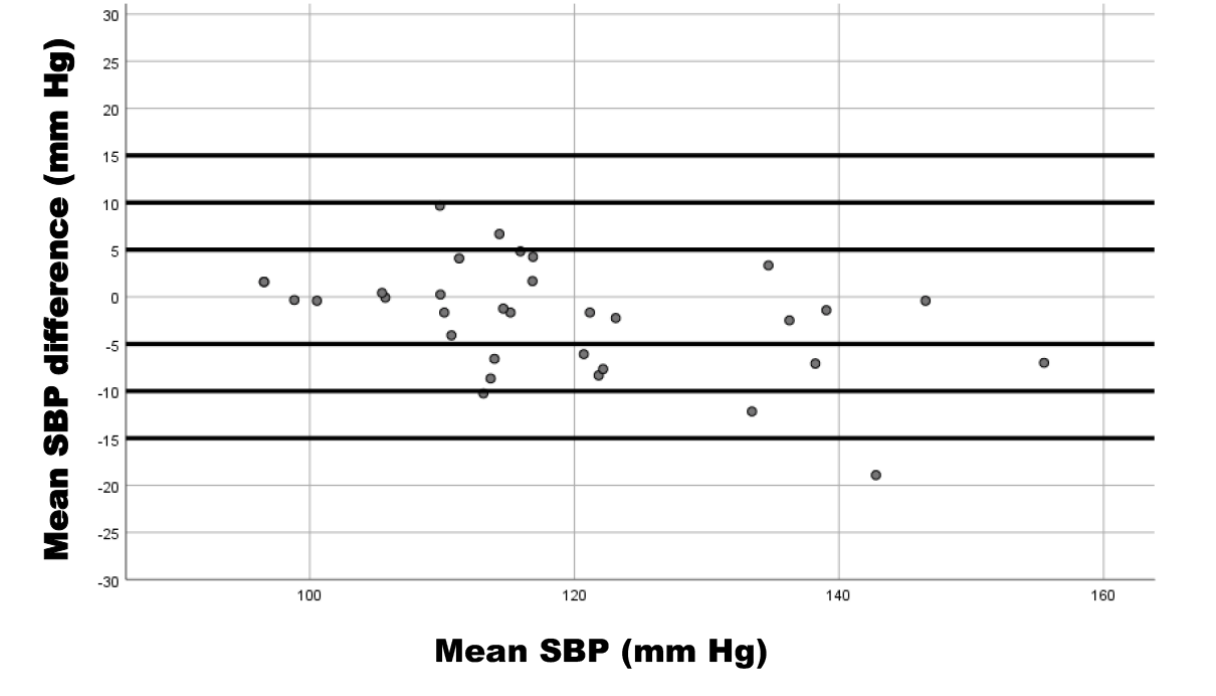
Figure 3. Bland-Altman plot of systolic blood pressure (SBP) measurement differences between the iHealth Track (test) and the Omron M3 (reference) devices in 33 participants. Mean SBP difference is the systolic difference between the devices; mean SBP is the mean systolic average values of the